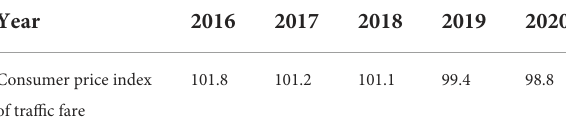
TABLE 8 The consumer price index of traffic fare (year